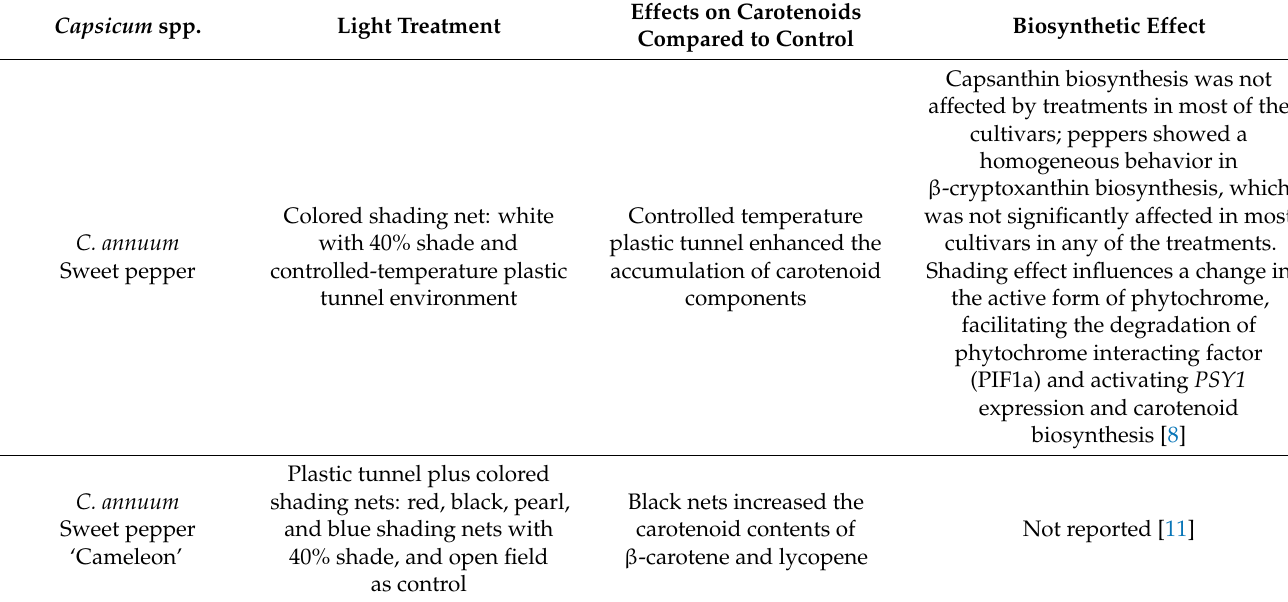
Table 2. Effect of light-condition treatments on the carotenoid content in Capsicum species. Capsicum